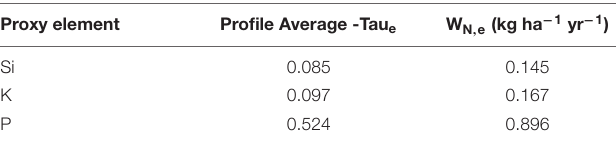
TABLE 1 | Estimates for N flux using a bedrock bulk density of 1.733 g cm − 3 , a denudation rate of 0.155 mm yr − 1 , and a bedrock N concentration of 0.064 wt. %.